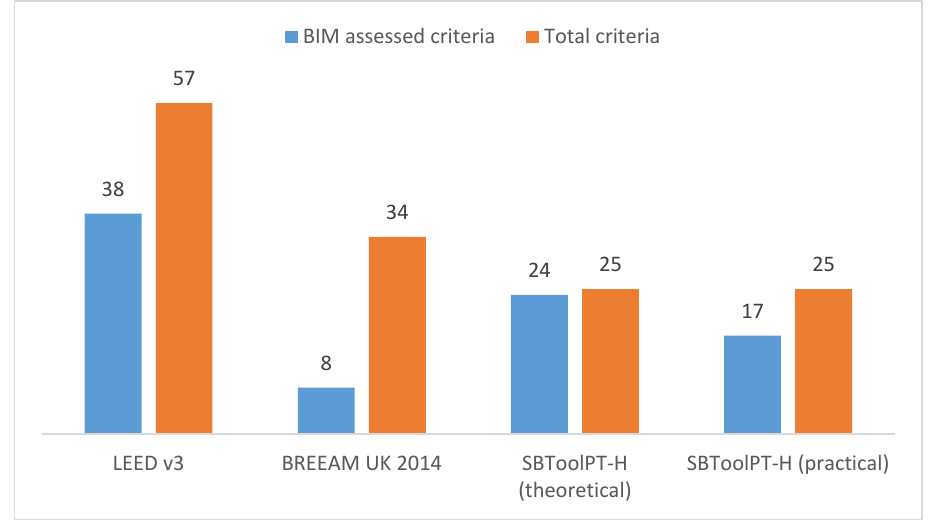
Figure 12. Number of LEED, BREEAM and SBTool criteria that is possible to assess with BIM.